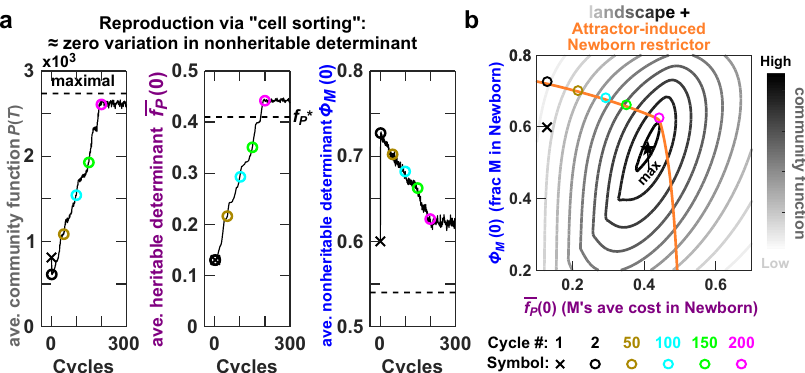
Fig. 3 Restriction in Newborn species composition can produce counterintuitive evolutionary dynamics and prevent the attainment of maximal community function. a Cost can evolve to be higher than what is optimal for community function. The evolutionary dynamics of the H – M community under a “ cell sorting ” community selection scheme (Methods) is plotted in black curves. Over each selection cycle, 100 Newborns matured into 100 Adult communities, and two Adults with the highest amount of Product were chosen to reproduce where each was randomly split into 50 Newborns. Chosen Adults were reproduced through cell sorting, and thus each Newborn had a total biomass very close to the target value of 100 and species ratio very close to that of the parent Adult. Community function determinants f P ð 0 Þ or ϕ M (0) were obtained from the Newborn stage of chosen Adults, and then averaged over chosen communities. The black dashed lines mark the theoretical maximum of P ( T ) (corresponding to the black star in b ) and the corresponding f ð 0 Þ P and ϕ M (0) required to achieve maximal community function. b Newborn restrictor constrains community function away from the theoretical maximum. Evolutionary dynamics of community function determinants ( fi rst cycle marked with a cross and subsequent cycles marked with circles) are plotted on top of community function landscape (gray contours) overlaid with the attractor-induced Newborn restrictor (orange curve). Compared with the landscape in Fig. 2c, the label of the x axis changes from f P , the cost of the clonal M population, to f ð 0 Þ , M ’ s average cost in a Newborn. In other words, determinants P de fi ned at the Newborn stage are predictive of the community function de fi ned at the Adult stage. This is because we have chosen maturation time to be short, such that M ’ s average cost does not change signi fi cantly over maturation (Supplementary Fig.